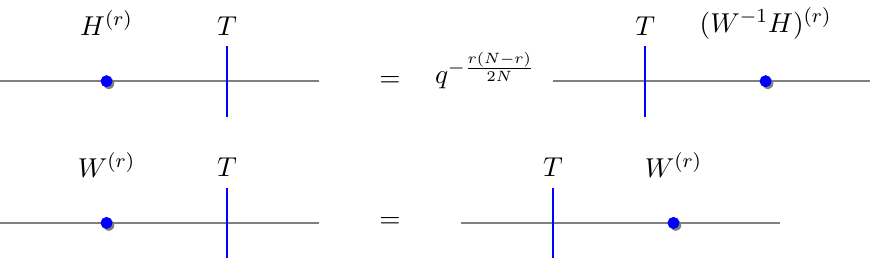
Figure 11 . The correlation function of the T duality interface between a pair of Dirichlet boundary conditions D X ( a ) and D X ( a 0 ).